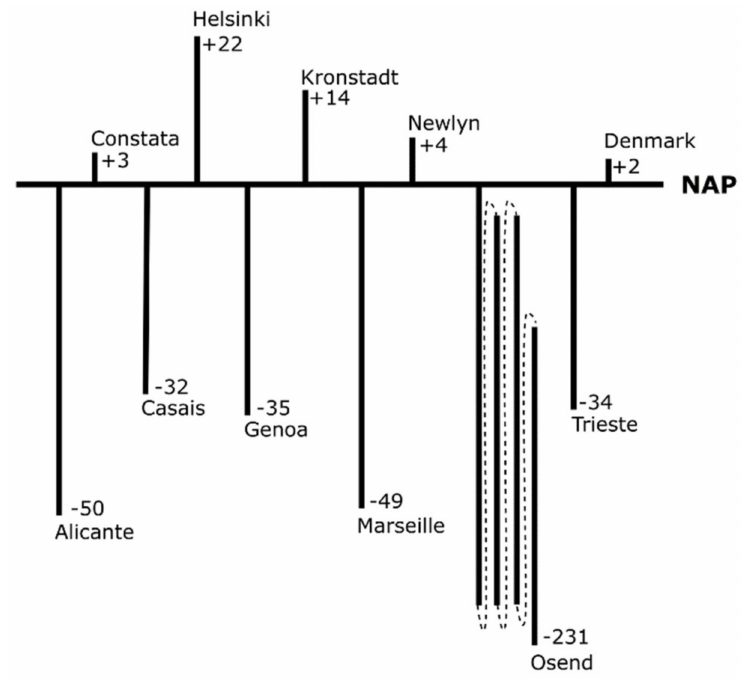
Figure 1. Mareographic stations in Europe and selected height reference systems. Source: